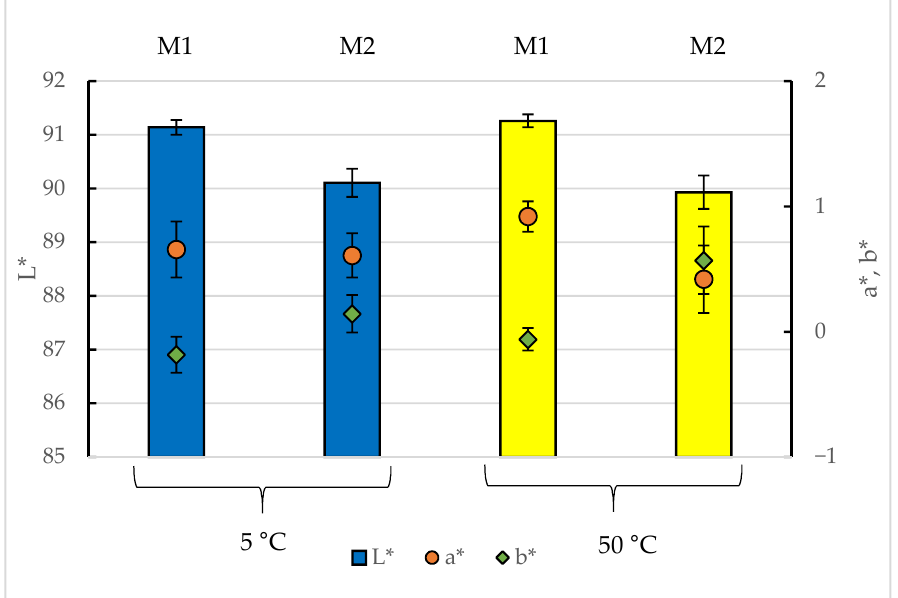
Figure 2. The plaque-staining agent-induced change in the experimental materials’ CIELAB pa- rameters with the temperature of the reaction: L* (lightness) presented in the form of columns, a* (expression of the red-green wavelengths) presented in the form of filled circles; b* (expression of the yellow-blue wavelengths) presented in the form of filled diamonds. M1—the brackets; M2—the brackets with the adhesive material. Error bars express the experimental and analytical uncertainty calculated as a standard deviation of the replicates. The experiments were repeated 3 times, and the measurements were performed 10 times per sample. The p < 0.05 was considered as the significant difference